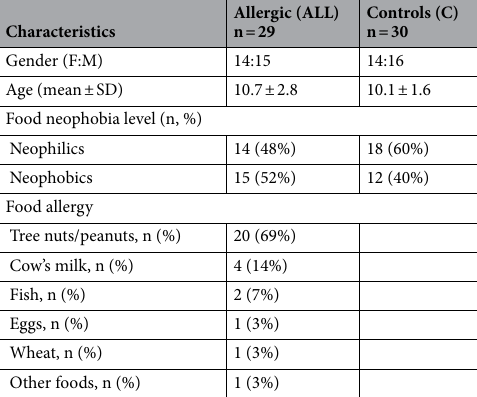
Table 1. General and clinical features of cases and